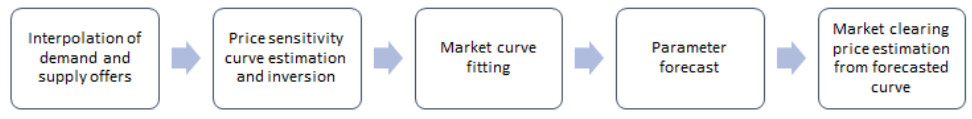
Figure 6. Flowchart of the proposed method for electricity price estimation with market curves